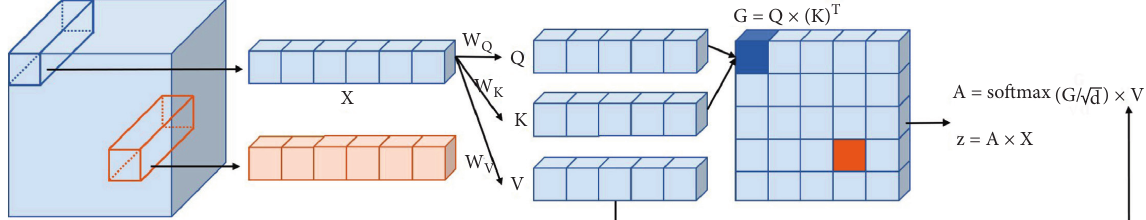
Figure 3: Illustration of the attention block.